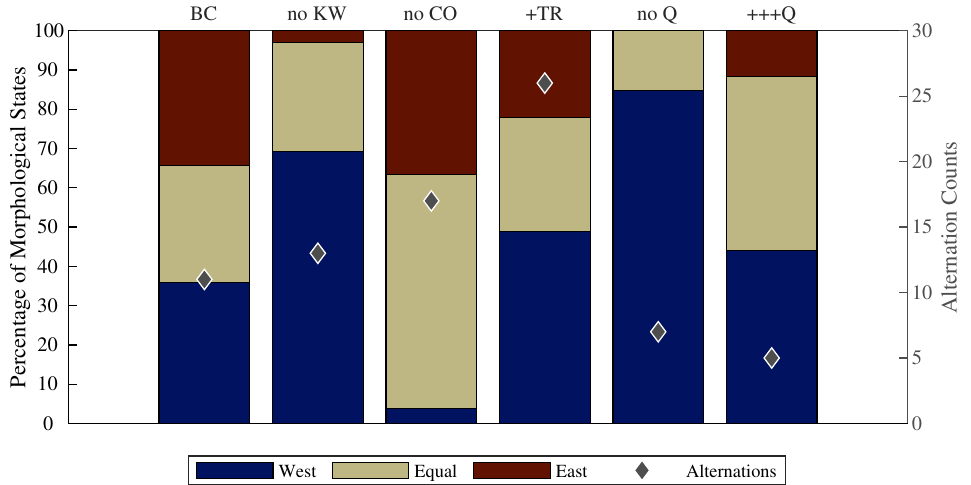
Figure 10. Comparison of the occurrence of channel dominance distribution (%) per scenario. With BC = base case, no KW = no Kelvin wave, no CO = no Coriolis effect, +TR = increased tidal range, no Q = no river discharge and +++Q = extreme river discharge. The number of alternations (changes between morphological states) is shown by the blue